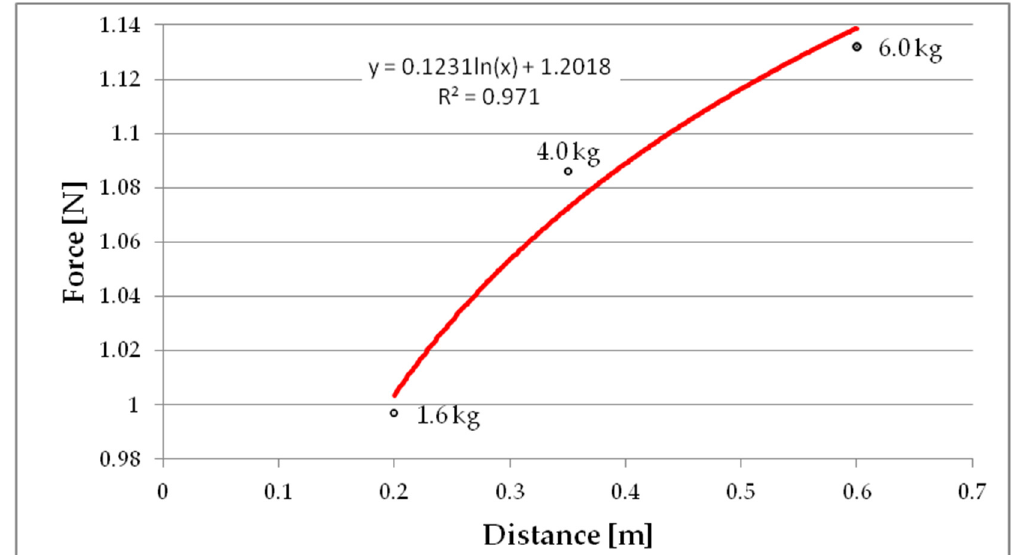
Figure 9. Correlation between the ice cover range and the magnitude of its impact on the trash rack (1.4, 4 and 6—mass of introduced ice). Table 2. Estimated C w values for different ice cover ranges in front of the trash rack.